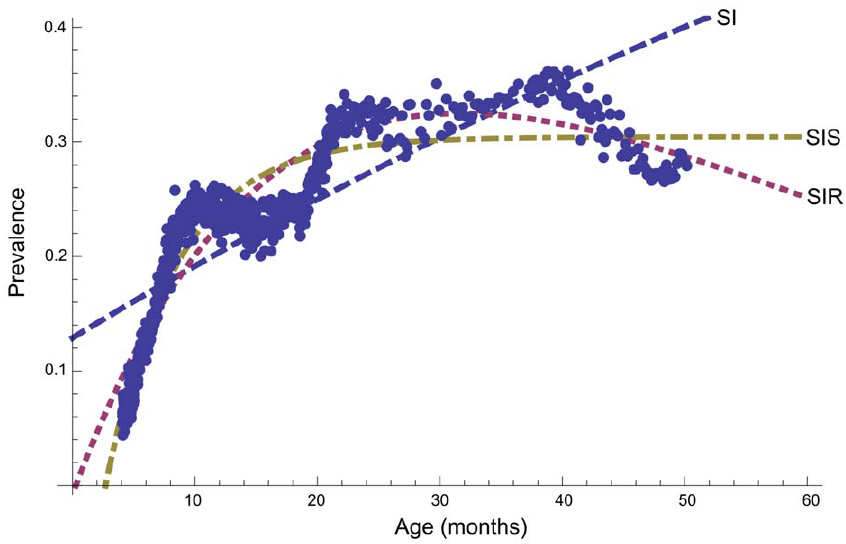
Figure 4. T.gondii seroprevalence in wild boar by age. Seroprevalence estimated by fitting the binormal mixture model to age groups including 100–200 animals plotted at the mean age of the group (dots); and predicted seroprevalence by age using SI, SIR and SIS compartmental infection models (lines).